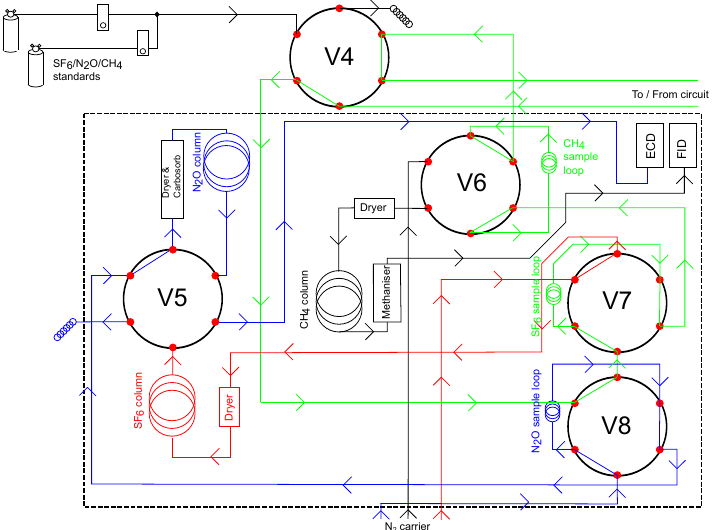
Figure 4. Schematic of the GC system used to measure SF 6 , N 2 O, and CH 4 , here in N 2 O inject mode. Each sample loop can be injected separately using the corresponding valve (V3, V4, and V5, respectively). For the ECD, the N 2 O and the SF 6 column can be selected with valve V2. For detailed description see